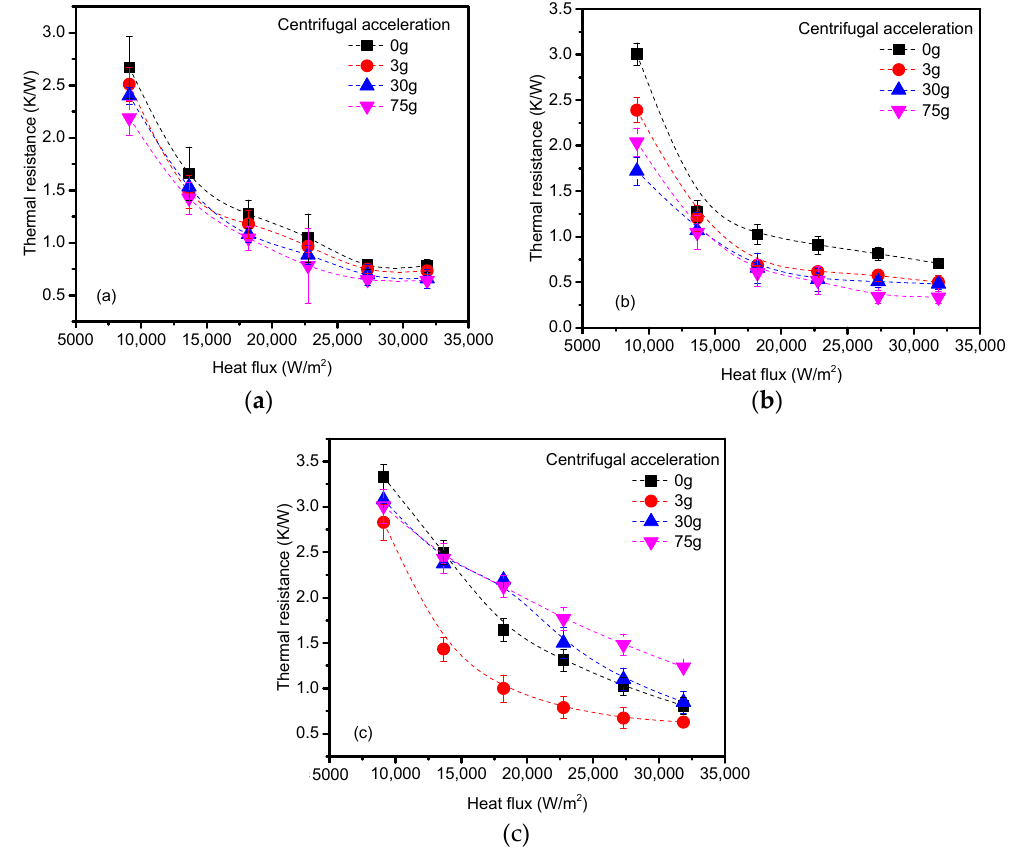
Figure 8. Effects of heat flux: ( a ) methanol; ( b ) acetone; and ( c ) DI water. Figure 8. E ff ects of heat flux: ( a ) methanol; ( b ) acetone; and ( c ) DI water.